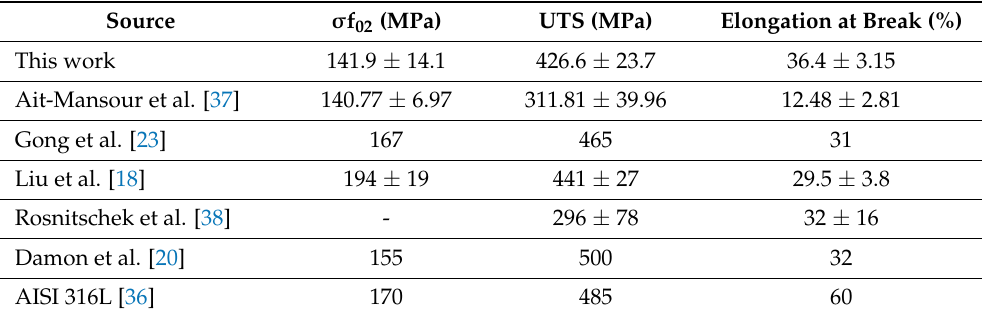
Table 3. Comparison of tensile properties among 316L specimens fabricated by means of the ME technique.